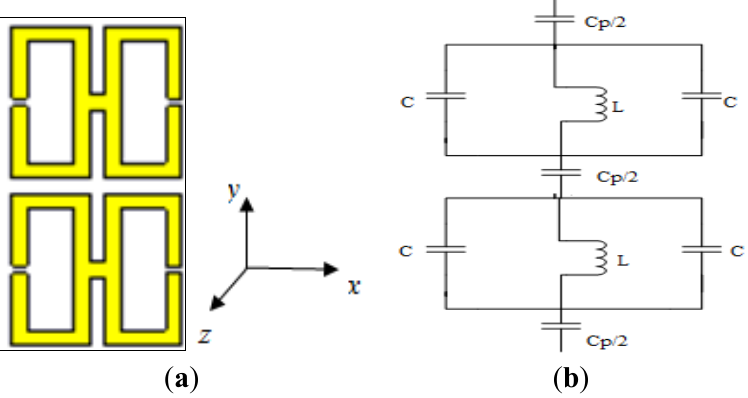
Figure 6. ( a ) The 1 × 1 array of the H-shaped unit structure; ( b ) the equivalent circuit of the 1 × 1 array of the H-shaped unit